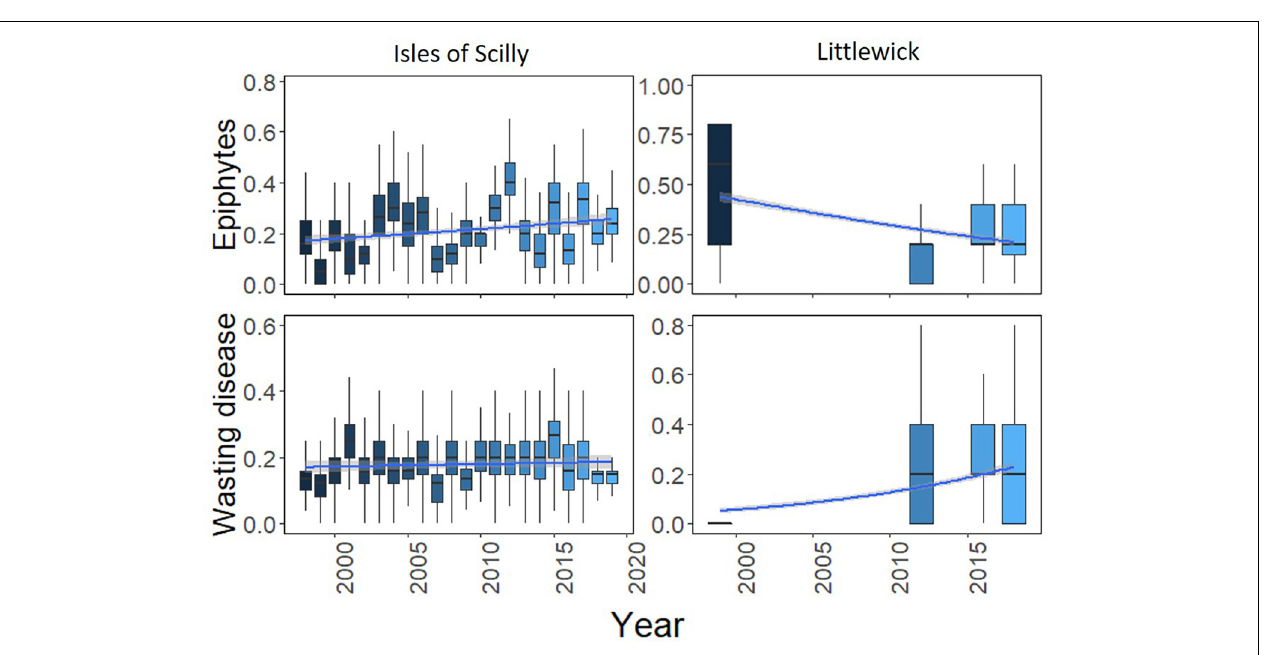
FIGURE 6 | Boxplots showing change in leaf condition (epiphyte cover and wasting disease) over time for Littlewick and the Isles of Scilly. The box-whisker represents the median (line) and interquartile range (box) with additional 1.5 × interquartile range shown as whisker. Scale is as a proportion based on the original scores, with temporal trendline in blue (GLM smooth with binomial errors for proportion data) with 95% confidence in grey either side. Outliers have been taken out for clarity (data provided by NRW, and Natural England, with data from this study included for Littlewick for